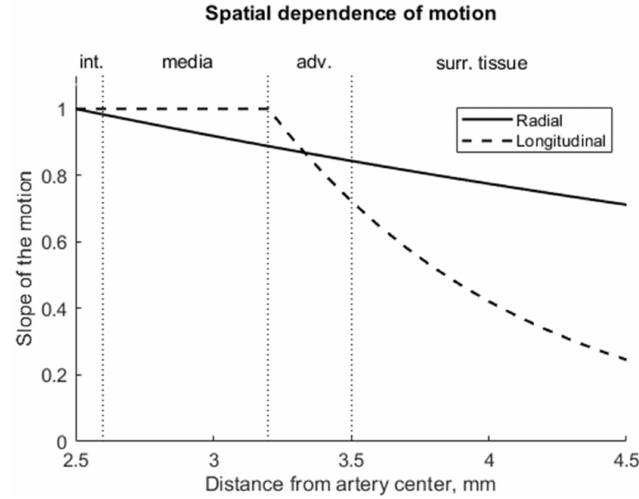
Figure 7. The amplitude of radial motion was greatest at the surface of the artery (2.5 mm) and decreased exponentially into the surrounding tissues; the amplitude of longitudinal motion was greatest at the intima–media complex (at 2.5–3.2 mm), decreased significantly into the ad- ventitia layer (3.2–3.5 mm) and, finally, the longitudinal motion amplitude was negligible in the surrounding